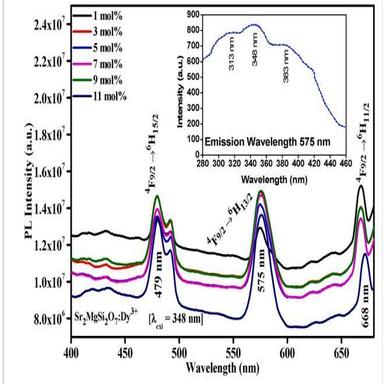
Photoluminescence spectra for Sr2MgSi2O7:Dy3þ NPs. Inset: Excitation spectrum of the sample of 7 mol % Dy3þ with emission center at 575 nm.